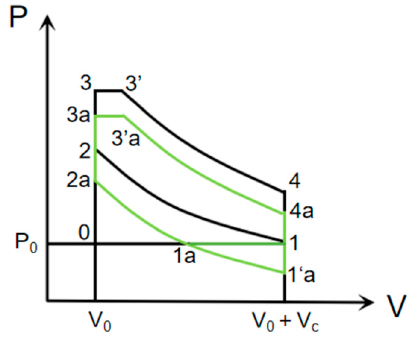
Figure 1. Dual cycle [5] and Miller cycle (EIVC) [6].